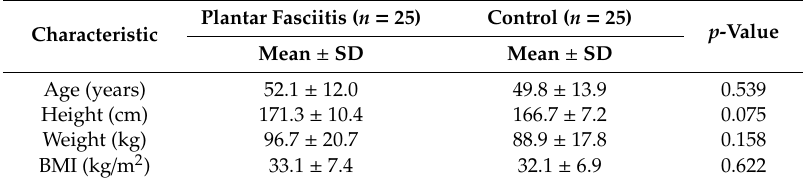
Table 1. General characteristics of participants ( n =